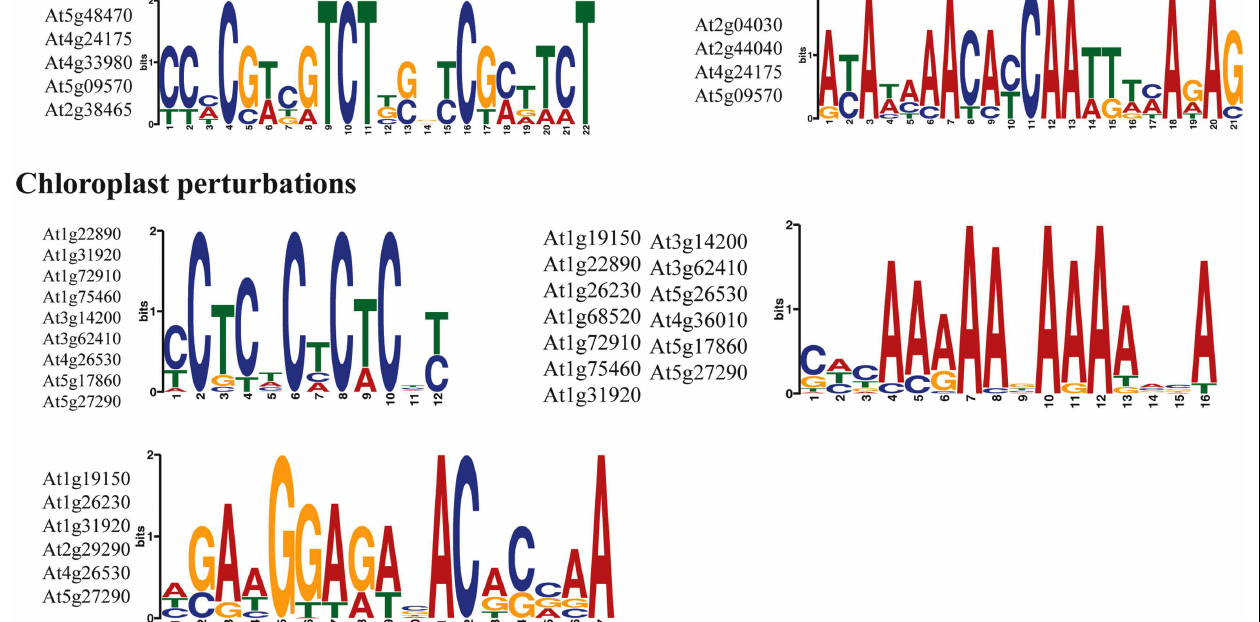
characterized include AtWHY3 encoding a DNA-binding protein that was shown to be involved in organellar genome stability (Marechal et al., 2009). Interestingly, AtWHY3 was shown to be located to plastids. AtWHY2 is active in the mitochondria and